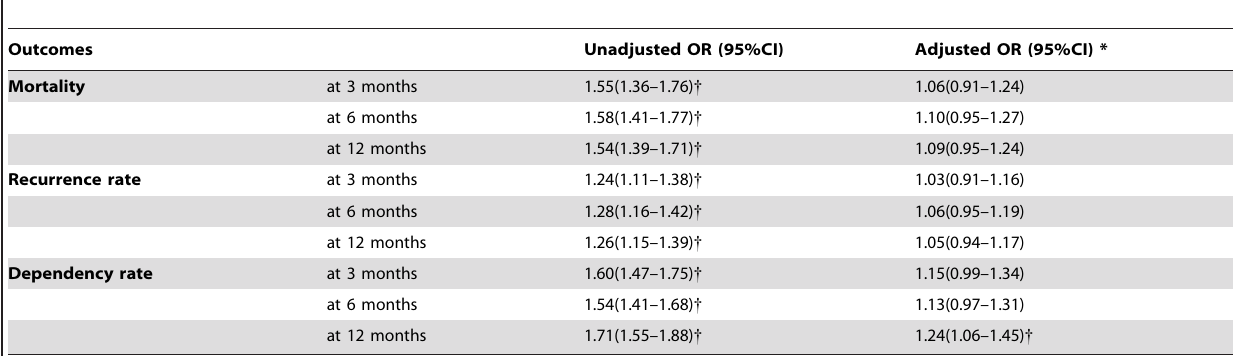
Table 5. Unadjusted and adjusted OR of outcomes at 3, 6, and 12 months for women to men.